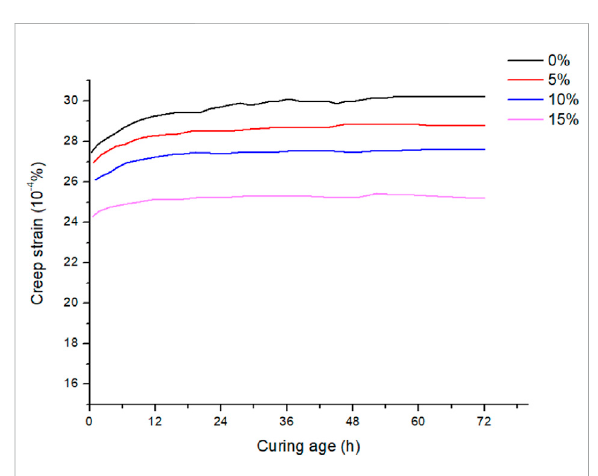
FIGURE 5 Effect of CSA on the creep value of cement paste.